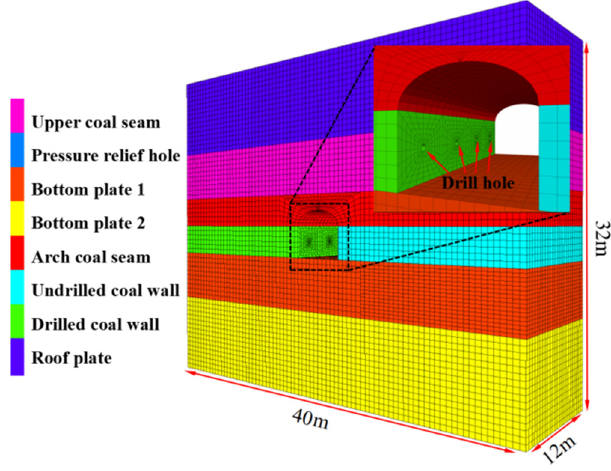
Figure 3. Numerical calculation model.